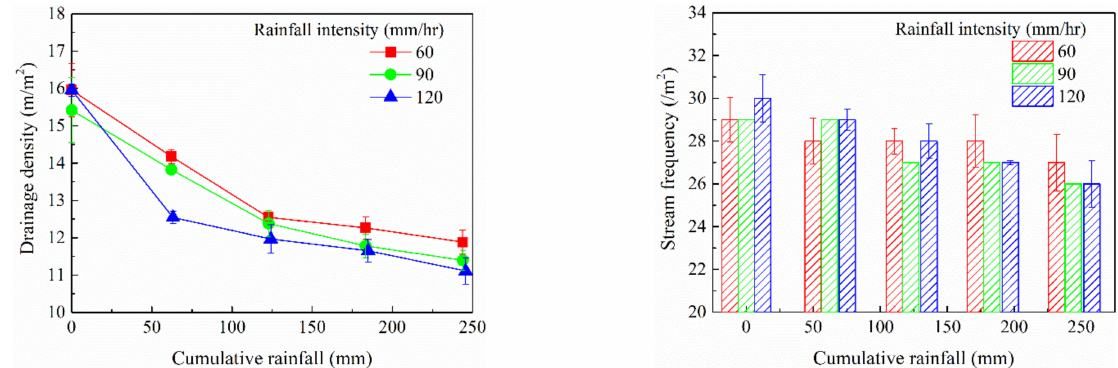
Figure 5. Changes of drainage density and stream frequency with cumulative rainfall.